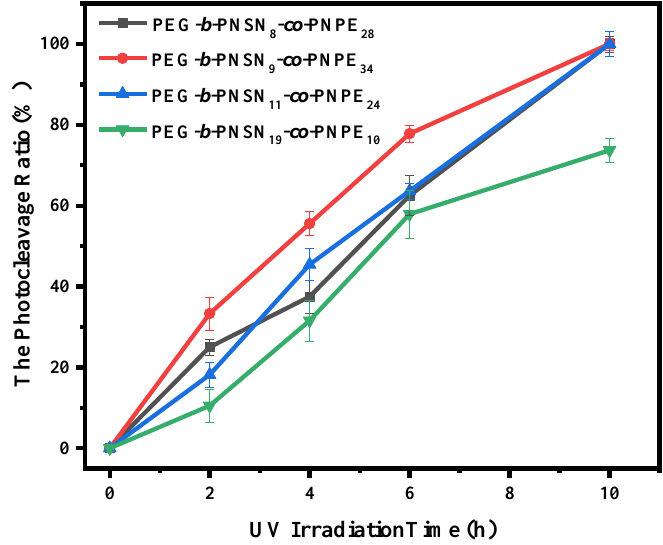
Figure 2. The photocleavage ratio of copolymers with different UV-irradiation time.